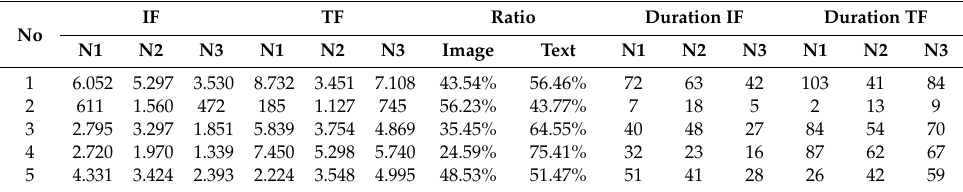
Table 6. Example of Eye-Tracker measurements per